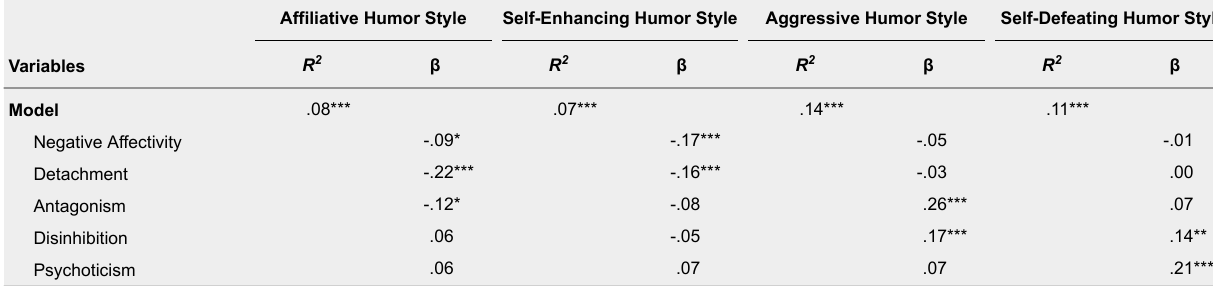
Regressions of Humor Styles on Pathological Personality